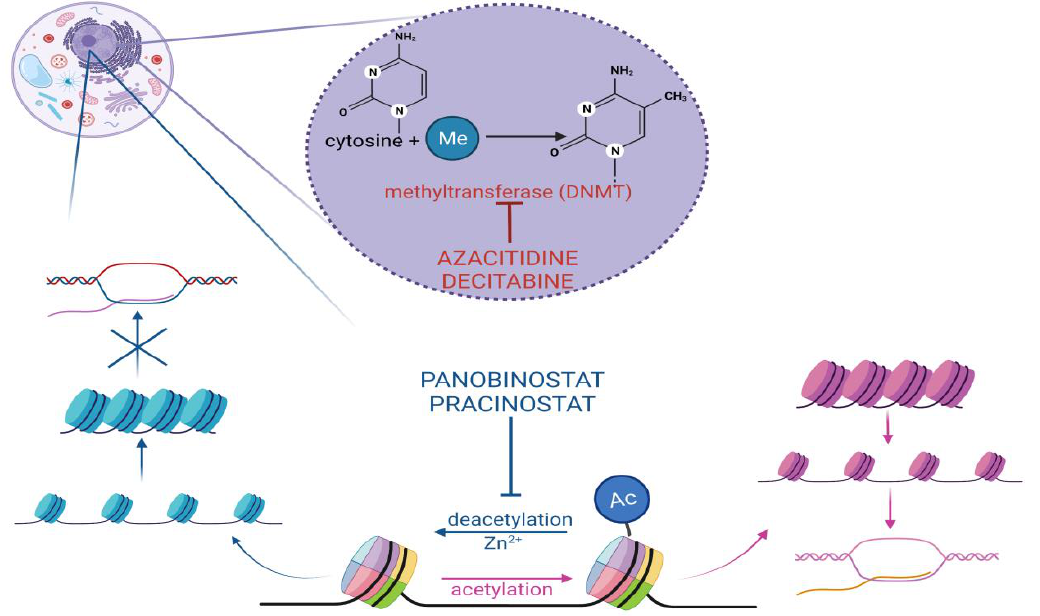
Figure 2. Mechanisms of action of epigenetic modifiers. Azacitidine and decitabine by inhibiting DNA methyltransferase reverse the aberrant hypermethylation of genes, which is a crucial epigenetic component of leukemic transformation. Pracinostat and panobinostat inhibit histone deacetylation, causing the re-expression of the genes involved in cell differentiation.